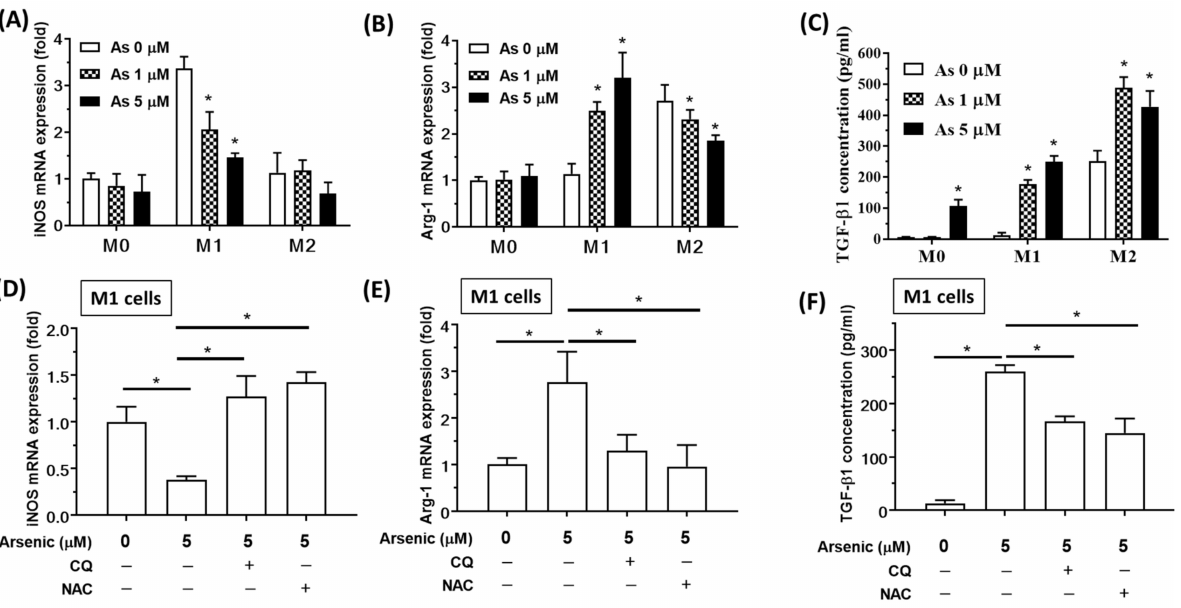
Figure 3. An autophagy inhibitor reduces arsenic-induced M2 polarization. THP-1-derived M0, M1, M2 macrophages were treated with 1 or 5 µ M arsenic for 24 h. ( A ) The expression of the M1 marker gene iNOS was analyzed by real-time PCR. ( B ) The expression of the M2 marker gene ARG-1 was detected by real-time PCR. ( C ) The release the of M2-associated EMT regulator TGF- β 1 as detected by ELISA. * p < 0.05, arsenic-treated vs. untreated, by the Kruskal–Wallis test (N = 6). ( D ) THP-1-derived M1 cells were treated with 5 µ M arsenic for 24 h, with or without the autophagy inhibitor CQ (10 µ M) or the antioxidant NAC (10 µ M). After the treatments, iNOS expression was analyzed by real-time PCR. ( E ) THP-1-derived M1 cells were treated with 5 µ M arsenic for 24 h, with or without CQ/NAC. After the treatments, ARG-1 expression was analyzed by real-time PCR. ( F ) THP-1-derived M1 cells were treated with 5 µ M arsenic for 24 h, with or without CQ/NAC. After the treatments, TGF- β 1 concentration in the supernatants was detected by ELISA. * p < 0.05 by the Kruskal–Wallis test (N =